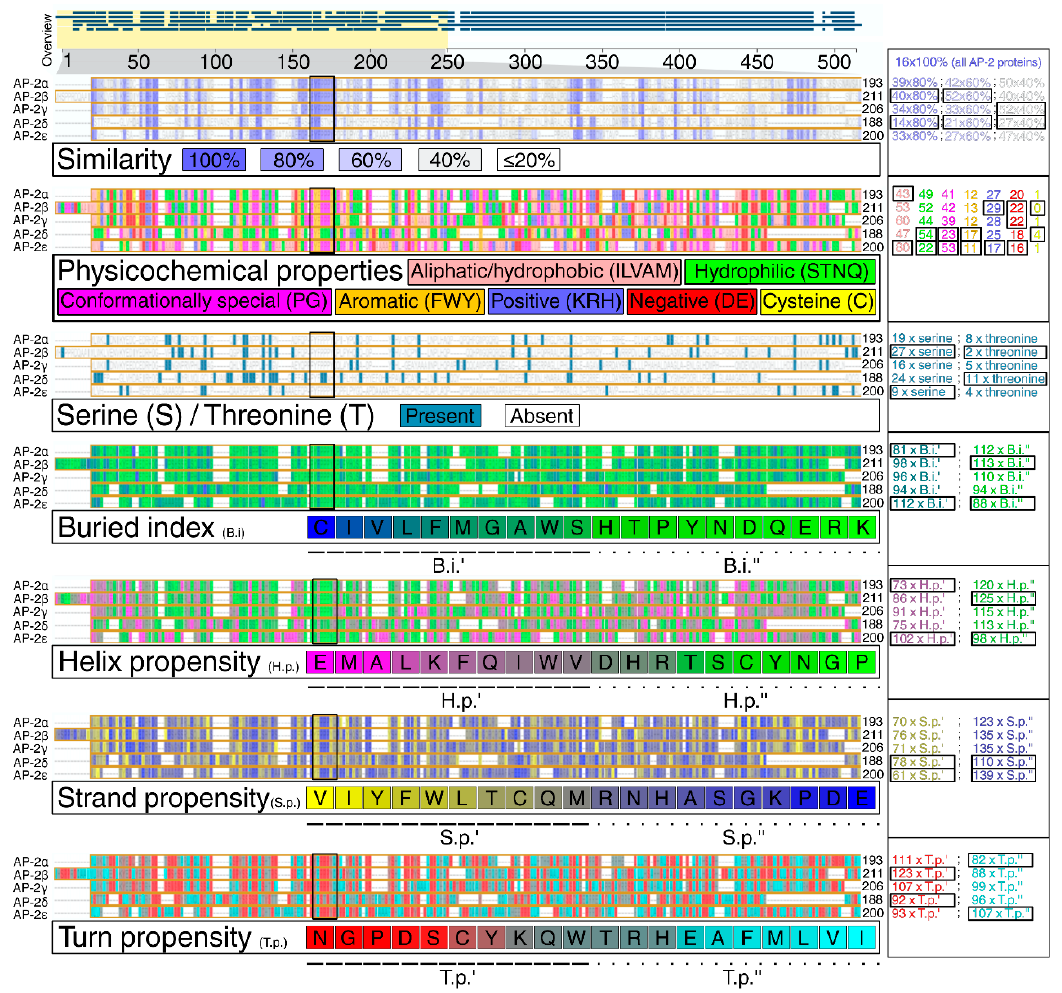
Figure 3. Emphasis on amino acids preceding the conserved “TF_AP-2” domain of AP-2 transcription factors. Data were acquired from the alignment of all AP-2 members using UniProt database. The quantity of amino acids presented for each protein is provided to the right of the sequence, including the far-right panel that subdivides residues based on a specific coloring scheme. Both extremes (the highest and the lowest number among AP-2 proteins) are framed in black. In the middle of the figure, the amino acid sequence encompassing the core of the proline-rich motif of AP-2 α / β / γ / ε is also framed in black. “Similarity” indicates the percentage identity of each amino acid between AP-2 proteins. Physicochemical properties are grouped using the Zappo coloring scheme; serines and threonines are also presented in a separate panel. Subsequent panels present structural properties which were dichotomized. Buried index—depending on the frequency of occurrence inside a protein, the amino acid residues are colored from blue (most frequent) to light green (less frequent). Helix propensity—the ability of an amino acid to form an α -helix, colored from magenta (the highest helix propensity) to green (the lowest one). Strand propensity—the ability of an amino acid to form a β -strand, colored from yellow (the highest strand propensity) to blue (the lowest one). Turn propensity—the ability of an amino acid to form a turn, colored from red (the highest turn propensity) to cyan (the lowest